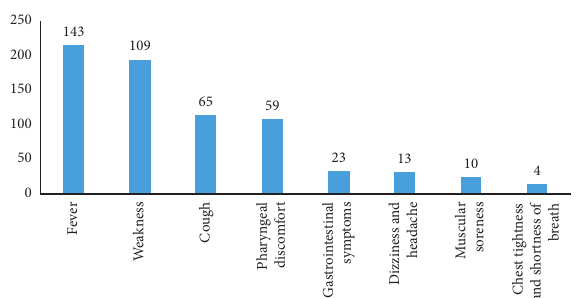
Figure 1: Analysis of the proportion of single symptoms in confirmed COVID-19 patients.